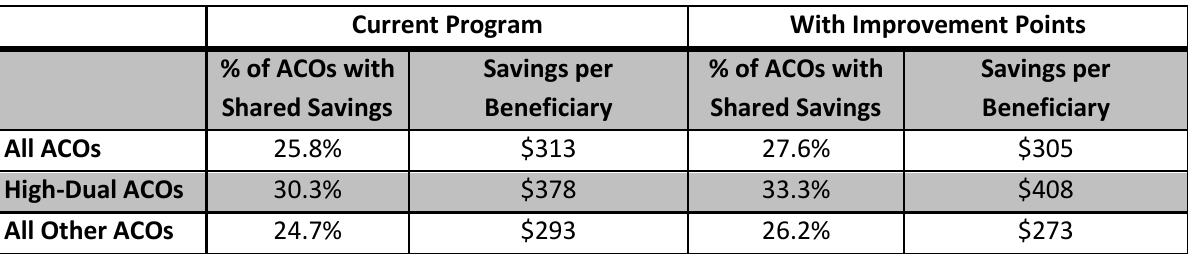
Table 9.13: Simulated Effects of Rewarding Quality Improvement in the Medicare Shared Savings